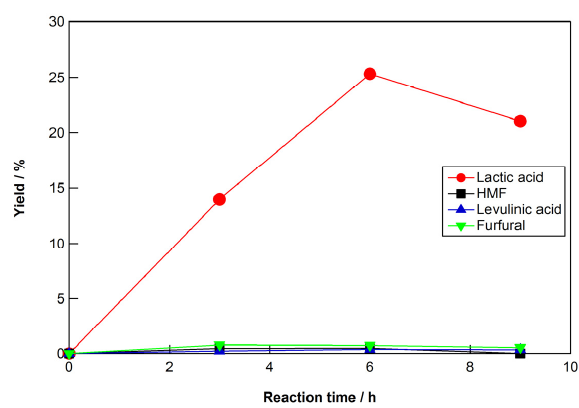
Figure 3. Product yields obtained when 10%ZrO 2 –Al 2 O 3 was used as the catalyst as a function of reaction time. Reaction conditions: ball-milled cellulose, 0.5 g; catalyst, 1.0 g; water, 50 g; reaction temperature, 473 K. HMF,